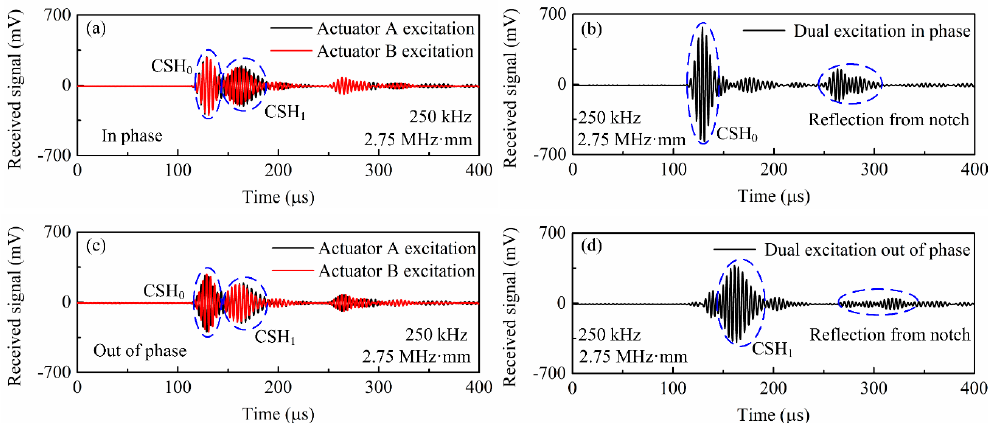
Figure 12. Selective generation of CSH 0 and CSH 1 modes by using dual excitation. ( a ) Actuator A and actuator B are driven one by one in phase, ( b ) the two transducers are simultaneously energized in phase, ( c ) the two transducers are driven one by one out-of-phase and ( d ) the two transducers are simultaneously energized